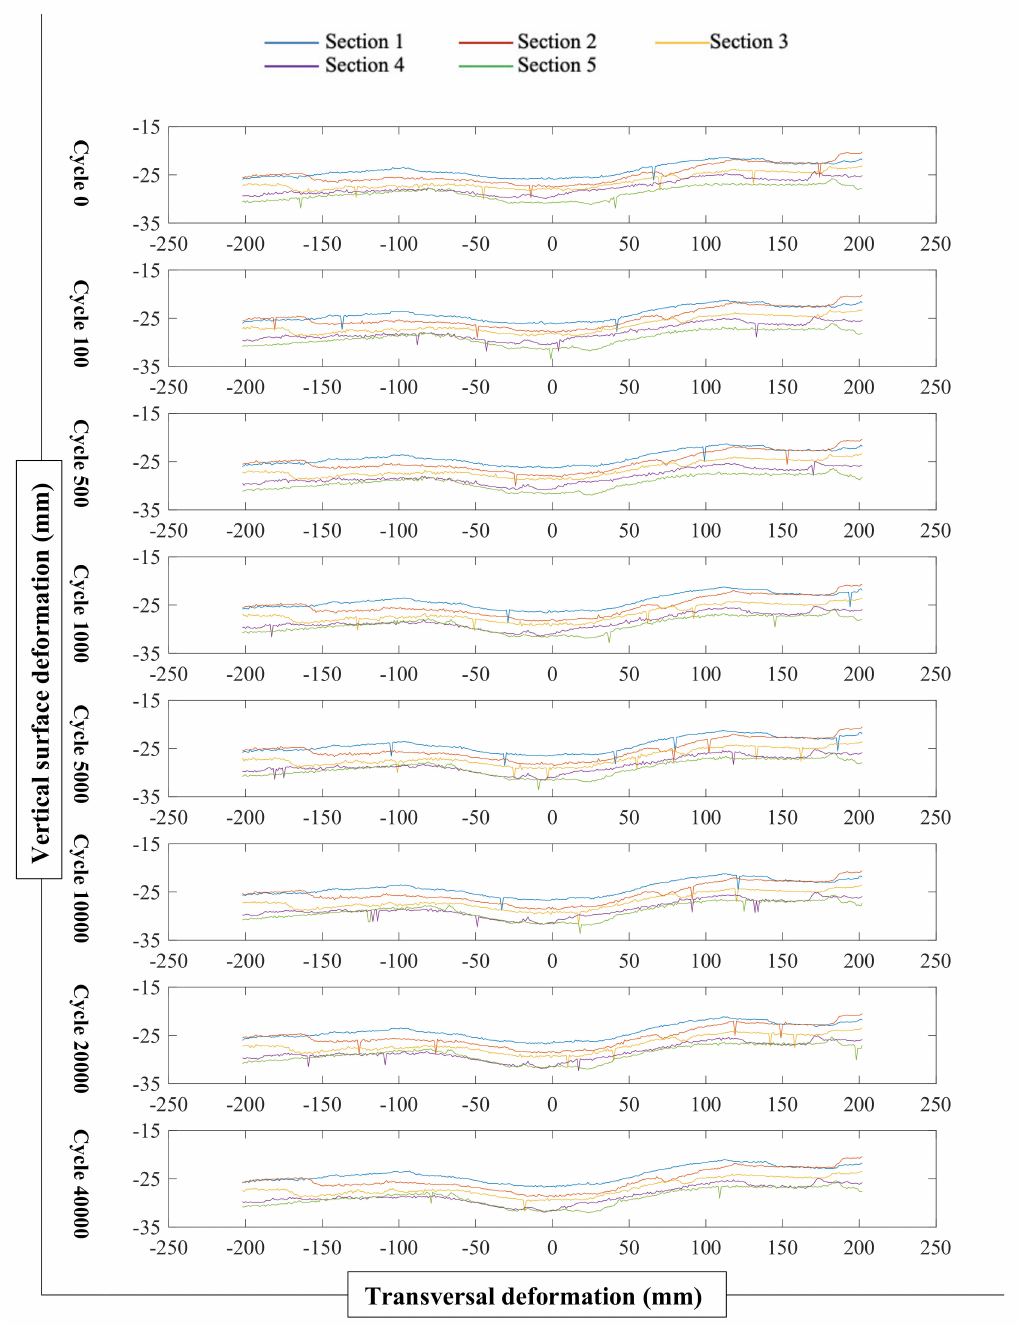
Figure 8. Profile data of all cross sections at different cycles for 15% RG + 20% CB + 65%